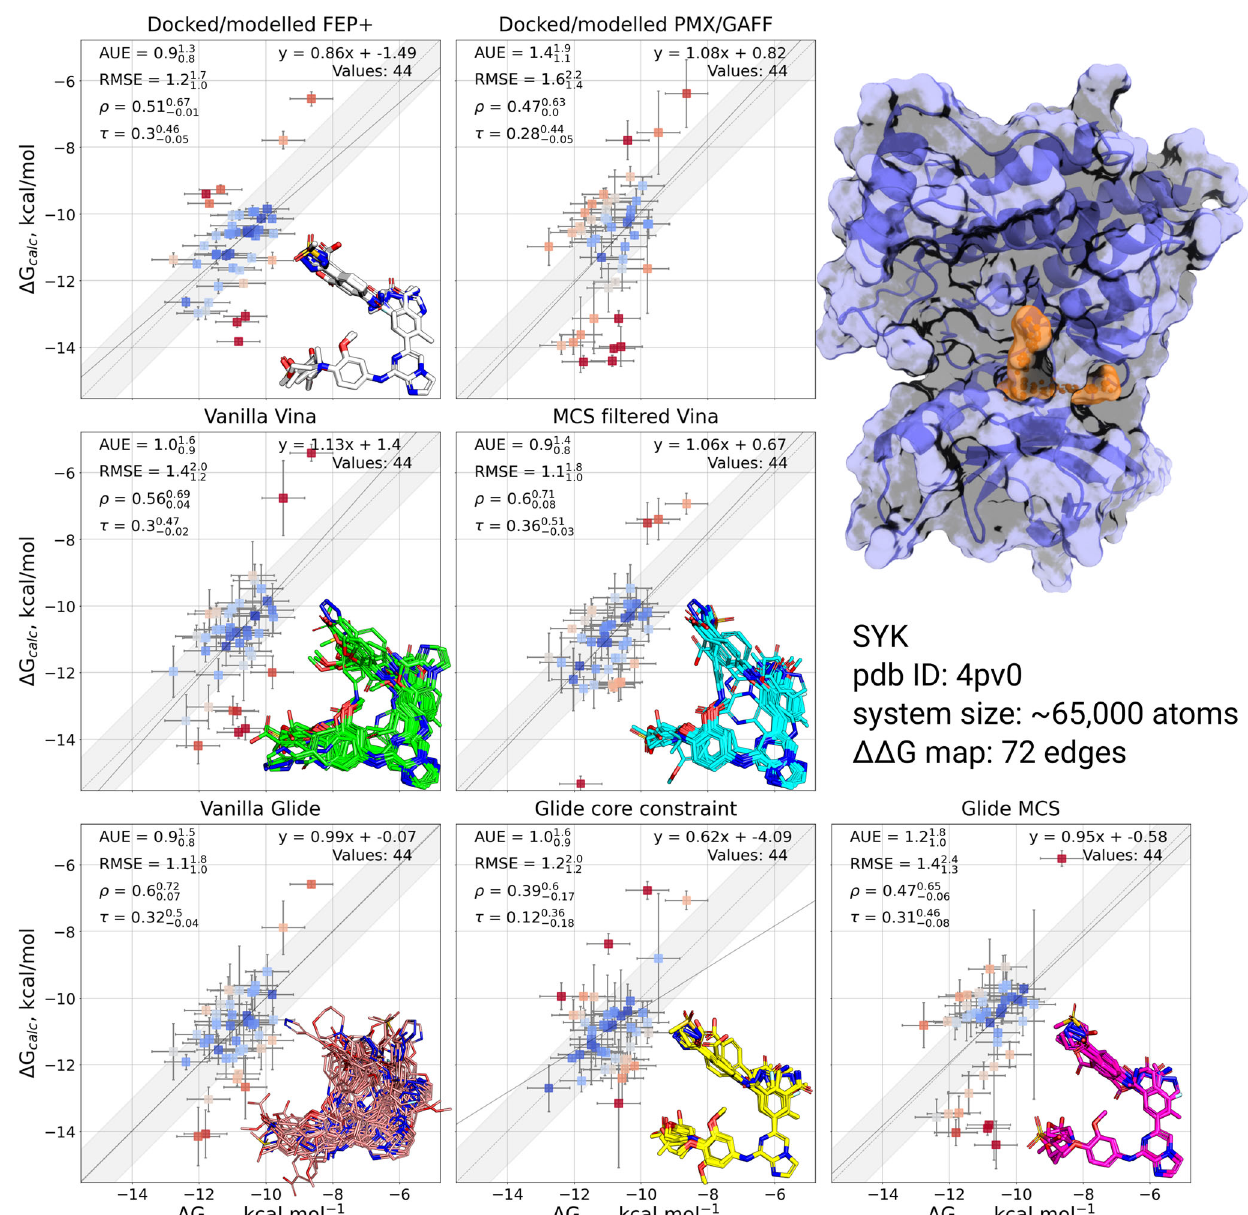
Fig. 4 Comparison of experimentally measured and calculated binding af fi nities for SYK protein-ligand system. The simulations were initialized with different starting structures (docked/modelled or docked only). The data in the panel Docked/modelled FEP + are from Schindler et al. 4 . The data in the panel Docked/modelled PMX/GAFF are from Gapsys et al. 13 . Overlays of starting ligand poses are inset into the corresponding plot. Experimental errors are taken from the original publication, whilst prediction errors correspond to the standard error over 3 simulation replicas also taking into account the bootstrapped uncertainty of individual free energy estimates. The shaded grey region corresponds to a 1 kcal mol − 1 deviation from experiment, and the solid line is a linear fi t through the data. The crystal structure with a bound ligand highlighted in orange is shown in the top